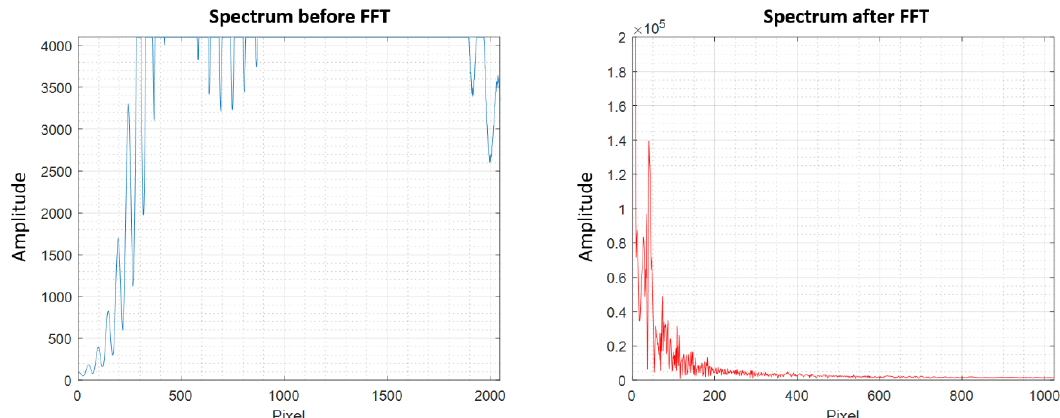
Figure 3. Measurement of a plane mirror without attenuation of the light intensity. On the left side the raw spectrum is found, a large part of the detector line is overexposed. On the right side the artifact sampled Fourier transformation of the signal is shown.